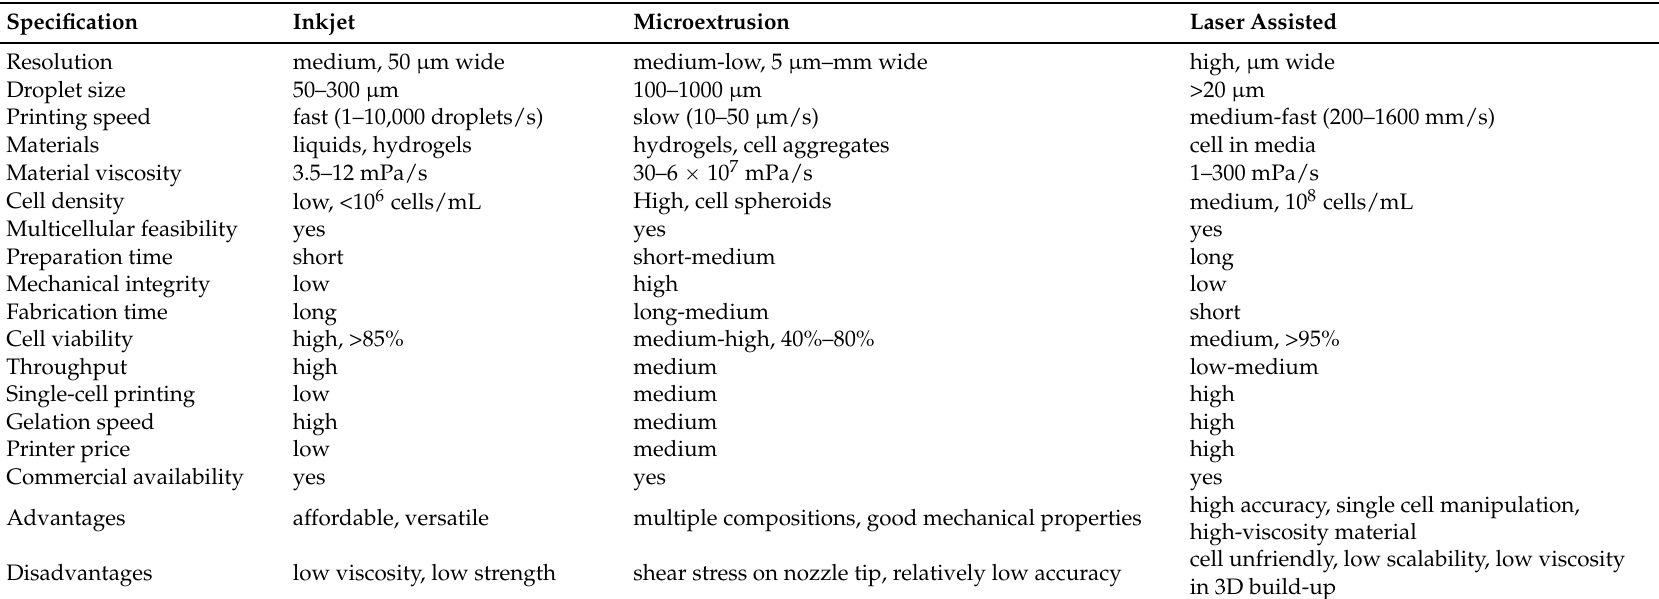
Table 1. Comparison of bio-printing